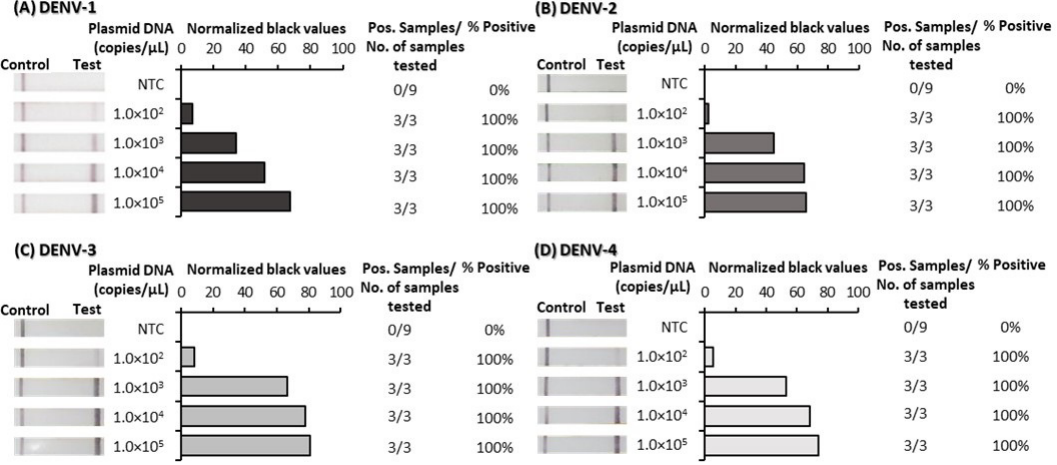
Figure 1. Analytical sensitivity determination of dengue virus (DENV) 1–4 recombinase polymerase amplification lateral flow detection (RPA-LFD) tests using plasmid DNA. Sensitivity testing used non-structural 5 (NS5) gene fragment plasmid DNA diluted 10-fold in water for DENV-1 RPA-LFD ( A ), DENV-2 RPA-LFD ( B ), DENV-3 RPA-LFD ( C ) and DENV-4 RPA-LFD ( D ). Images of lateral flow strips (LFS) with two bands (control and test band) indicates the sample is positive for respective DENV plasmid DNA, and single control band indicates a valid reaction with negative sample. Photograph of lateral flow strips with control bands (all samples) and test bands (positive samples) compared to copy number of serially diluted plasmid DNA (copies/μL) and no template control (NTC) (left). Normalised pixel density (normalised black values) from the lateral flow test strip displayed (middle). Positive (Pos.) results compared to number (No.) of samples tested at that dilution was used to calculate the percentage of positive tests performed at that dilution (right).